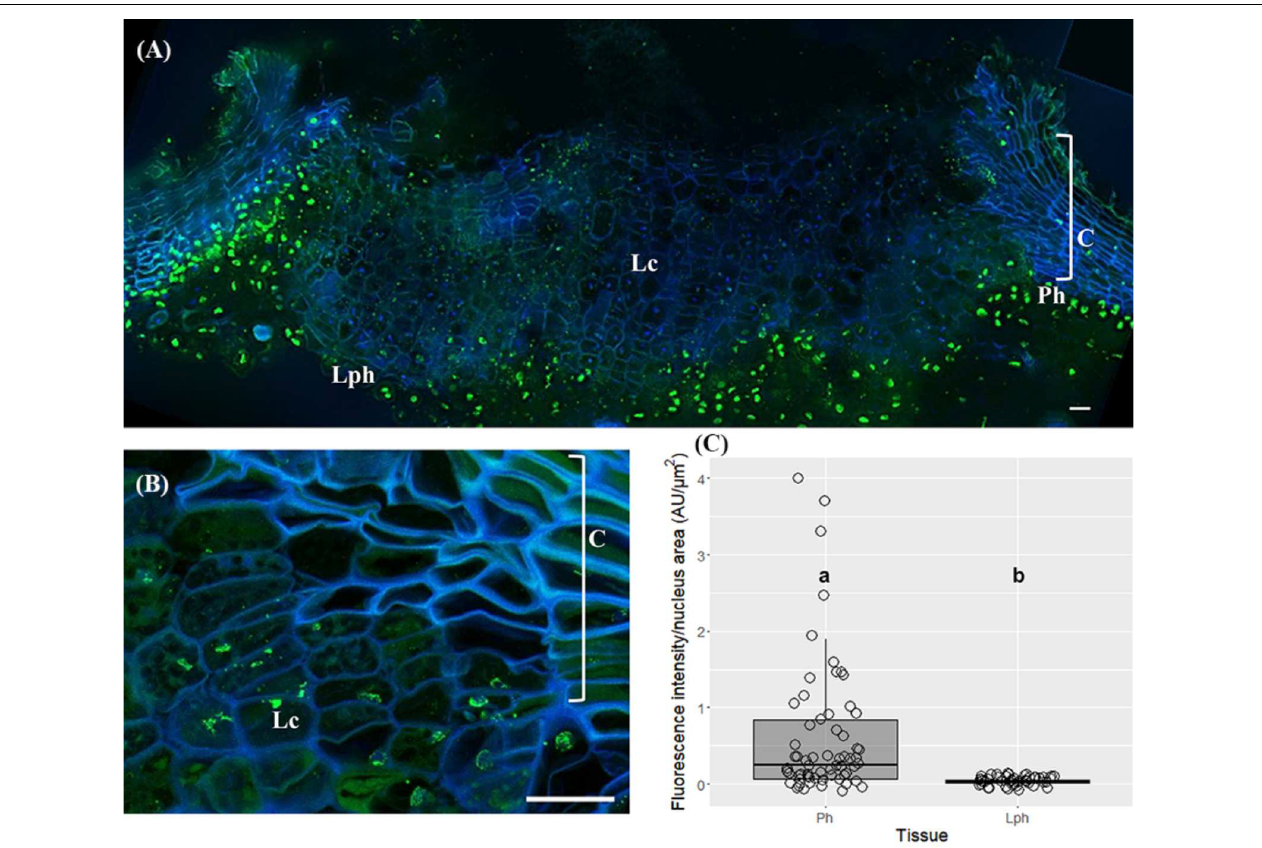
FIGURE 5 | Immunolocalization of 5-methylcytosine (5-mC) in lenticels from three-year-old sprigs. Less intense 5-mC signals in lenticular cells compared with the contiguous tissues like lenticular phellogen, phellogen, cork cells, and cortex (A) . (B) Fragmented nuclei of lenticular cells showing 5-mC signals. (C) Lenticular phellogen exhibit significant lower levels of 5-mC than the contiguous ‘cork’ phellogen; different small letters indicate significant differences. DNA was counterstained with DAPI. Bars = 10 µ m. Lph, lenticular phellogen; Ph, phellogen; Lc, lenticular cells; C, cork cells; Co,